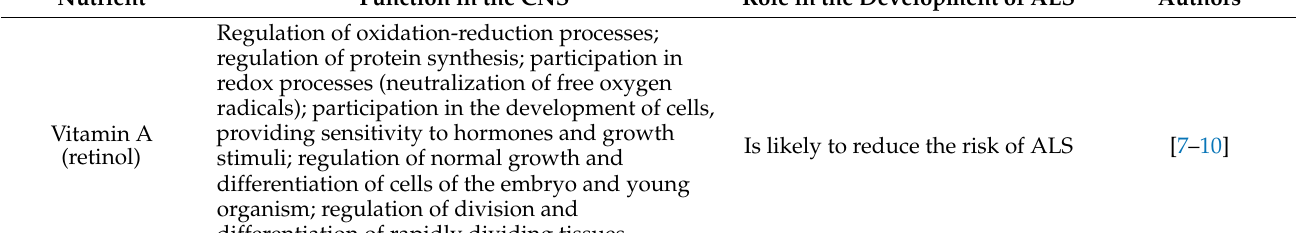
Table 1. The role of vitamins and other nutrients in the functioning of the nervous system and the development of ALS. Nutrient Function in the CNS Role in the Development of ALS